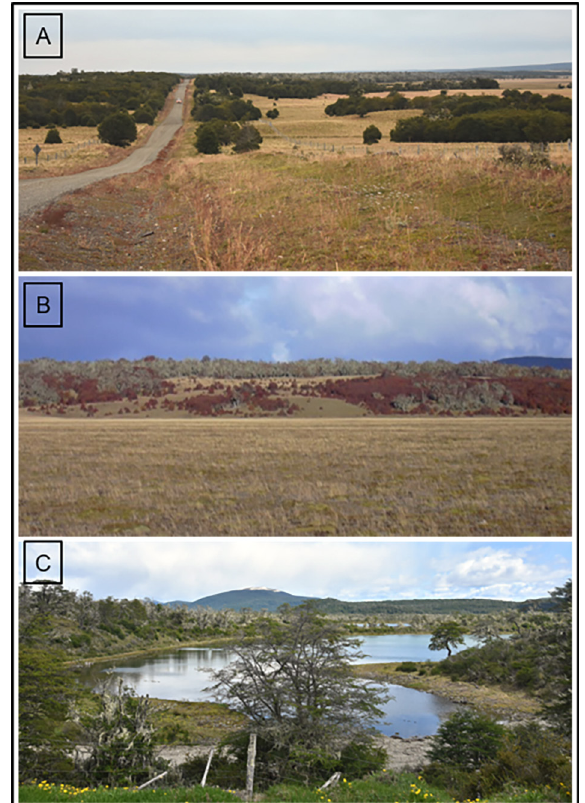
Fig. 7. Landforms belonging to the LGM in central Tierra del Fuego. A – Río Fuego terminal morainic complex facing the N along with RPF in the western side of the valley; B – Yehuin moraine and paleo-lake view to the SW; in front, the flat relief of the paleolake at the foot of the moraine; C – Tolhuin kettle and mound topography seen besides NR3; the kettle was flooded by meltwater forming shallow